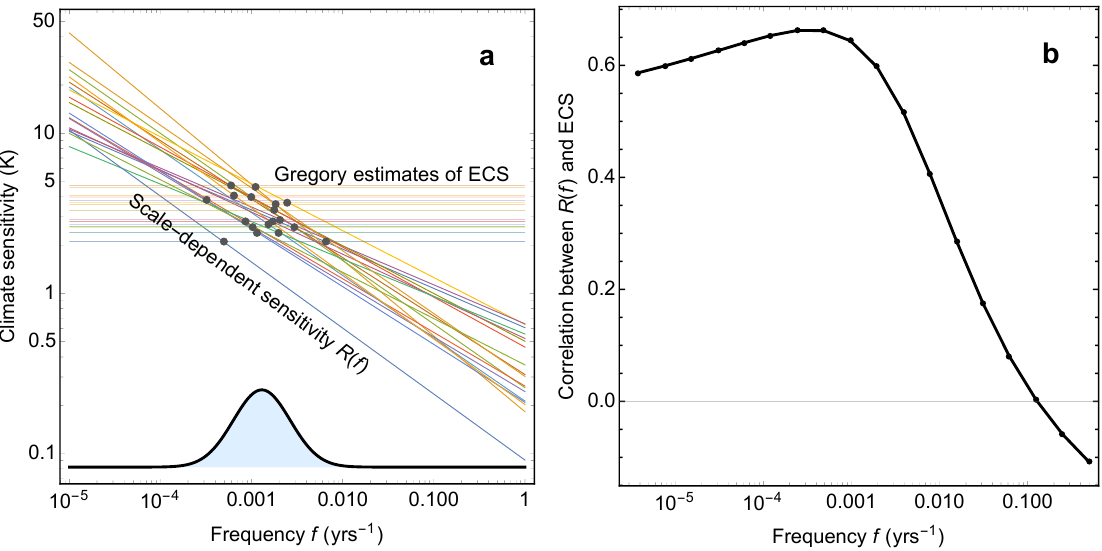
Figure 2. ( a ) The sloping lines are double-logarithmic plots of the scale dependent sensitivity R ( f ) for each ESM in the ensemble. The different slopes correspond to different β -estimates. The horizontal lines indicate the ECS of the ESMs obtained from the Gregory plots and reported in [1], and the black dots indicate for which frequency f we have R ( f ) = ECS for each model. ( b ) Correlation (over the ensemble of ESMs) between the scale-dependent sensitivity R ( f ) and the Gregory estimate of the ECS. The correlation coefficient is plotted as a function of the frequency f